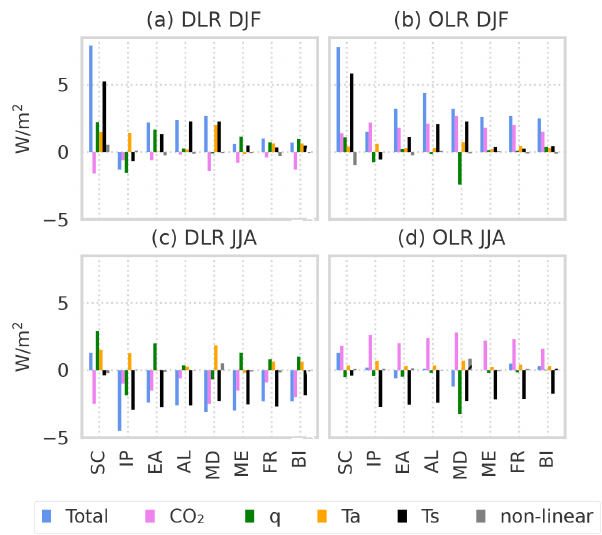
Figure 5. Differences in DLR (a, c) and OLR (b, d) for the win- ter (a, b) and the summer season (c, d) between CARBON and GRASS simulated with BUGSrad. Blue bars show total differences in DLR and OLR. The other bars show the respective contributions of CO 2 (pink), Q a (green), T a (yellow), and T s (black) to changes in DLR and OLR. Black, yellow, and green bars represent biogeo- physical effects on the longwave radiation balance with afforesta- tion, and pink bars represent biogeochemical effects. The gray bar is the residuum, which is attributed to non-linear effects.